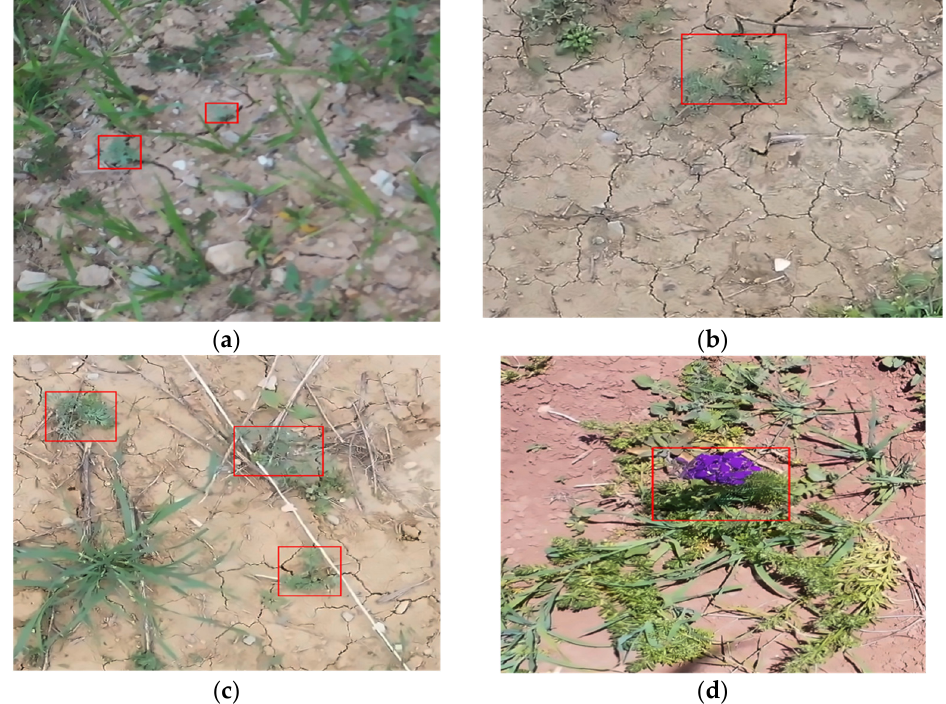
Figure 1. Consolida Regalis weed growth stages: ( a ) first stage, ( b ) second stage, ( c ) third stage, and ( d ) fourth stage.